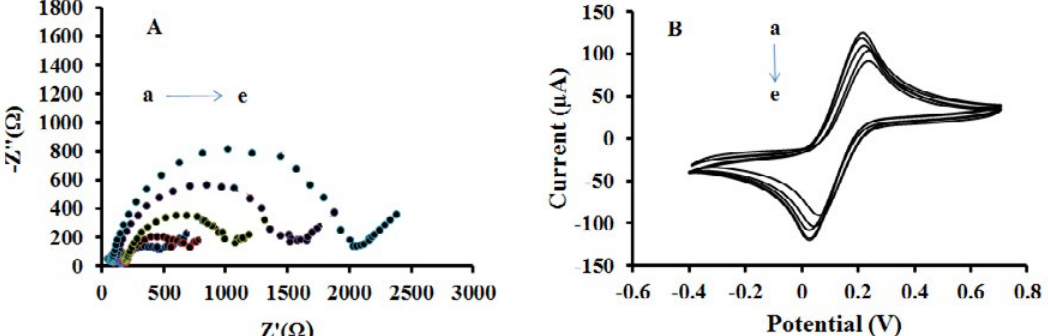
Fig. 2 Fig. 2. (A) Recorded EIS for the different steps of the modified electrode: (5 mmol L -1 [Fe(CN) 6 ] 3-/4 , KCl 0.1 mmol L -1 ), in 0.1 mmol L -1 PBS (pH=7.5) at (a) SPCE, (b) GQDs-N-S / SPCE, (c) AuNPs/GQDs-N-S / SPCE, (d) Ab/AuNPs/GQDs-N-S, (e) BSA/Ab/AuNPs/ GQDs-N-S. (B) Typical CV studies of [Fe(CN) ] 3-/4 (a) to (e) are the same as 6